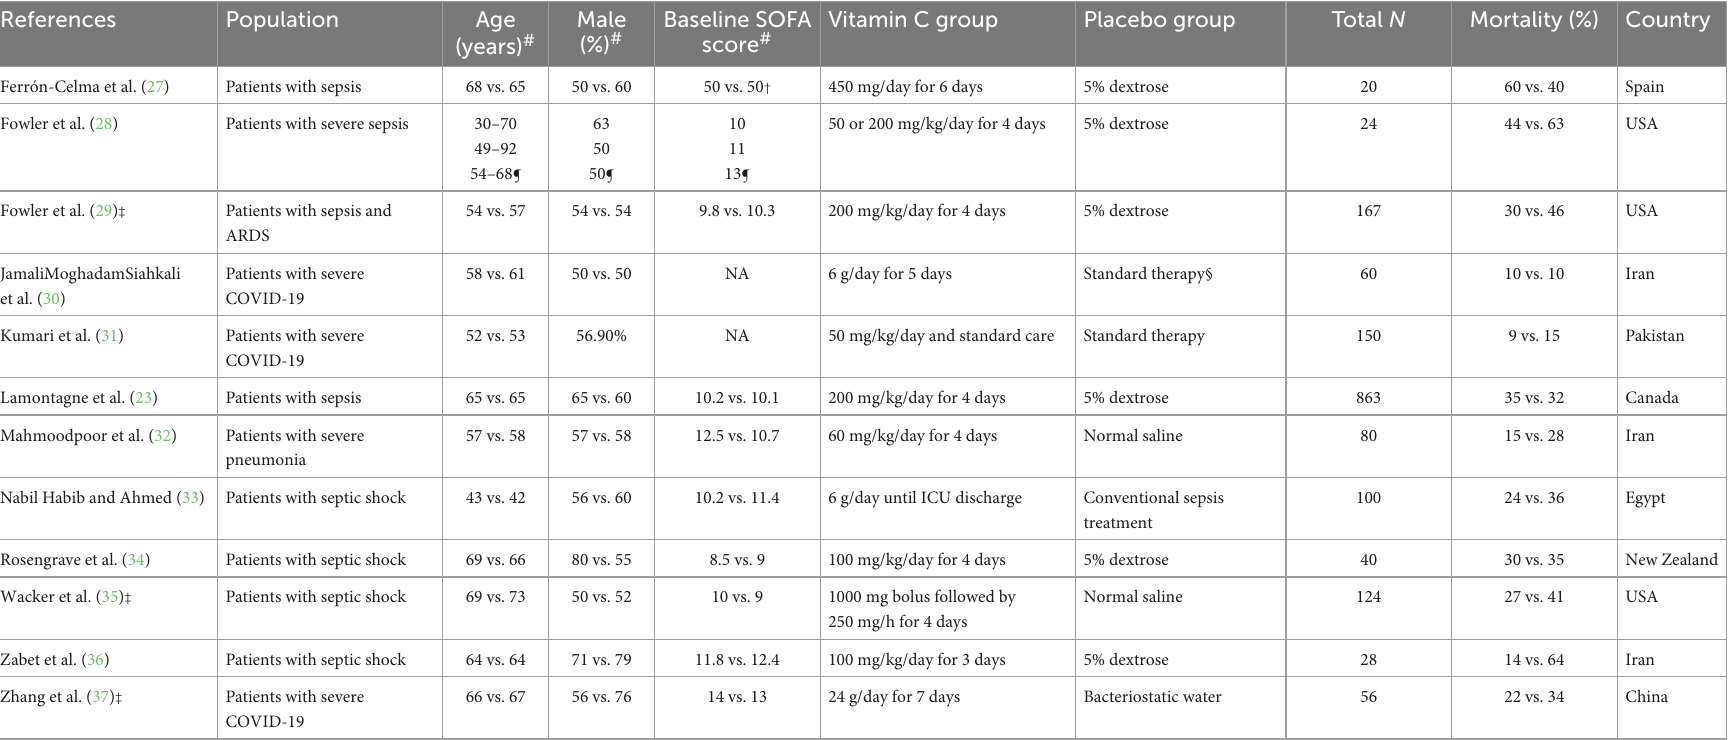
TABLE 1 Characteristics of studies ( n =